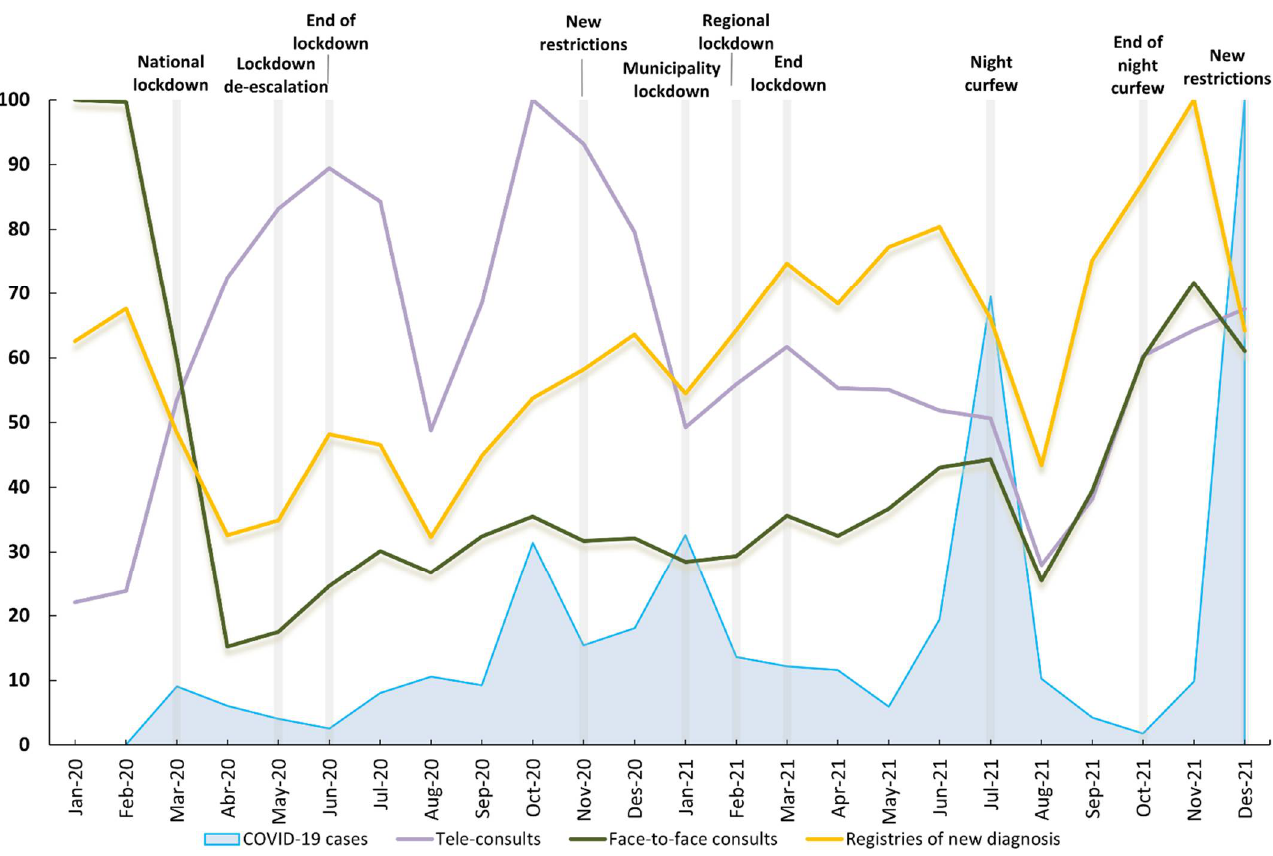
Figure 2. New diagnoses (excluding COVID-19 cases), tele-consults, face-to-face consults and number of COVID-19 confirmed cases in the study area from January 2020 to December